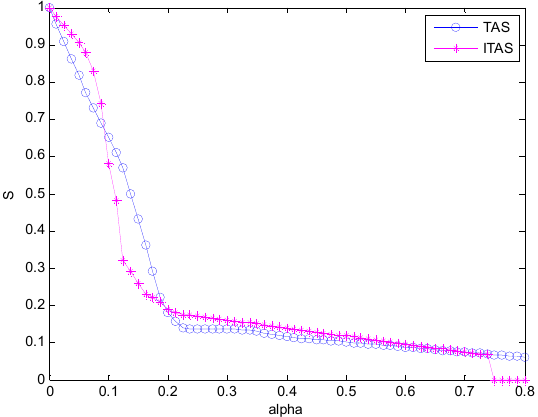
Figure 7. Invulnerability analysis under different attack strategies Table 5. Data statistics under different attack strategies